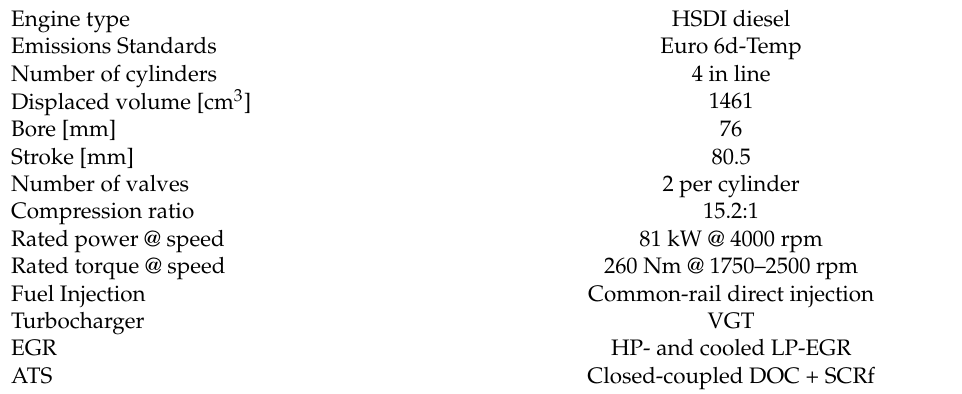
Table 2. Main specifications of the engine.